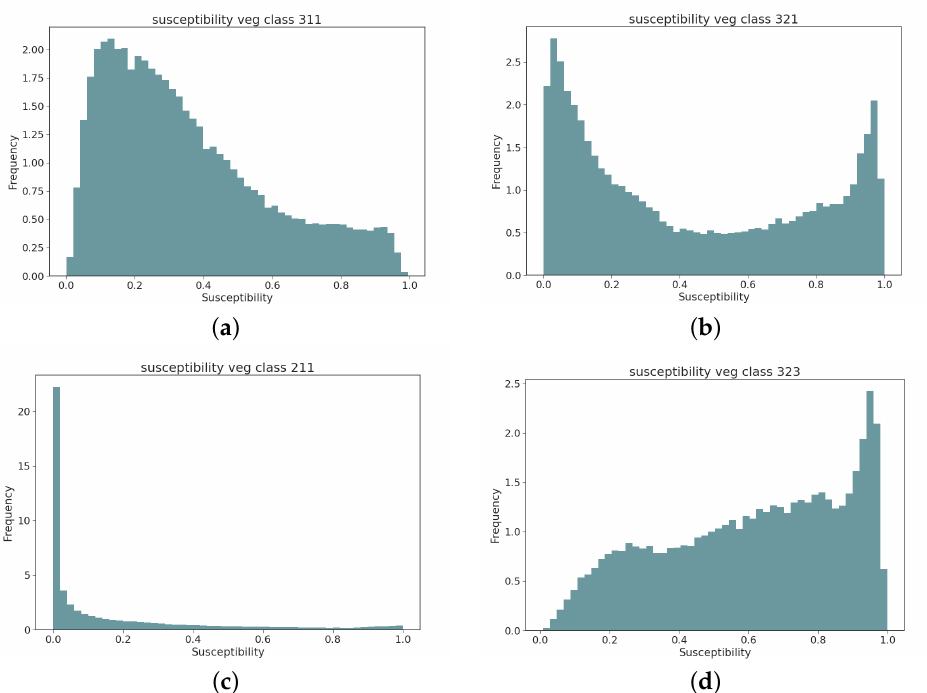
Figure 12. Susceptibility distribution of the four most important neighboring vegetation classes according to the feature rank of Figure 11. ( a ) Broad leaved, CLC code 311; ( b ) Natural grassland, CLC code 321; ( c ) Arable land, CLC code 211; ( d ) Sclerophyllous, CLC code 323.